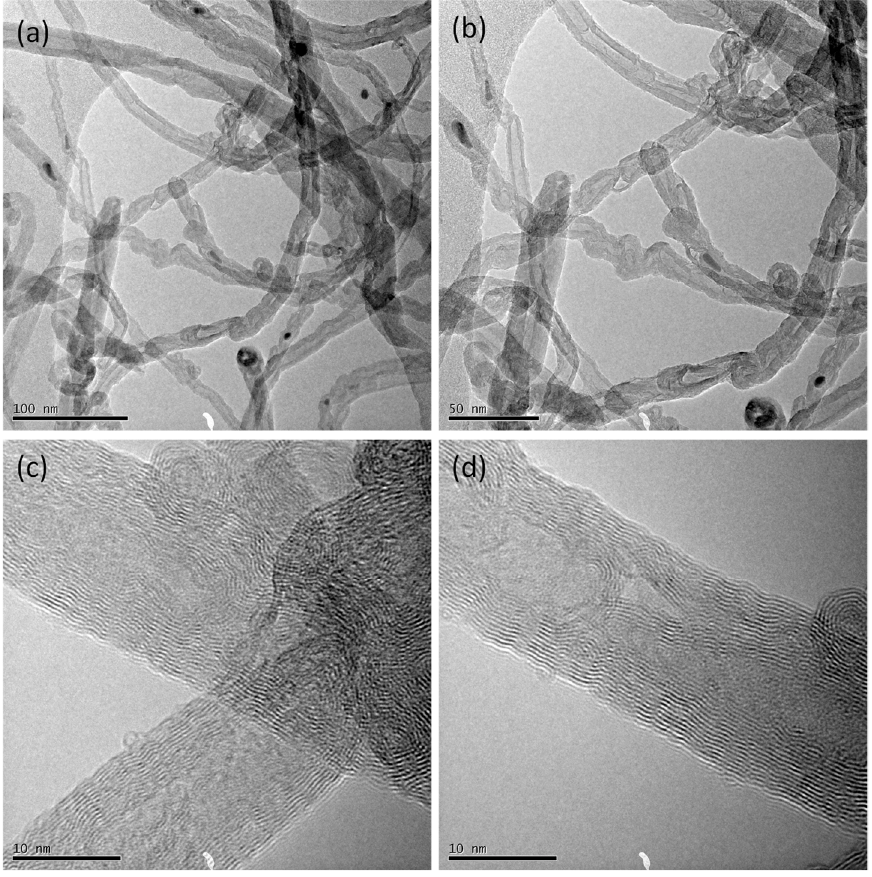
Figure 10. Transmission electron microscopy (TEM) of multi-walled carbon nanotubes (CNTs) grown via the catalytic carbon vapour deposition (CCVD) process at: ( a ) 100 nm scale bar, ( b ) 50 nm scale bar, ( c , d ) 10 nm scale bar.